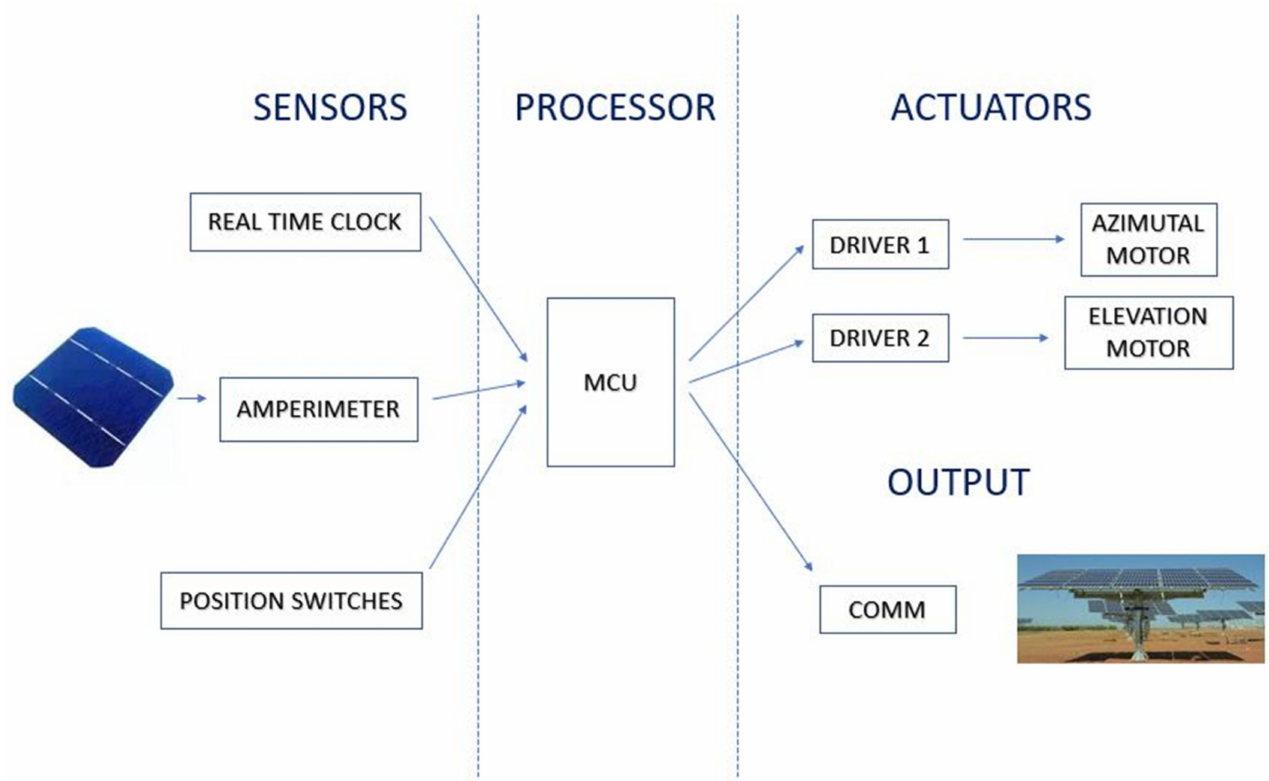
Figure 4. Scheme of principle of the proposed